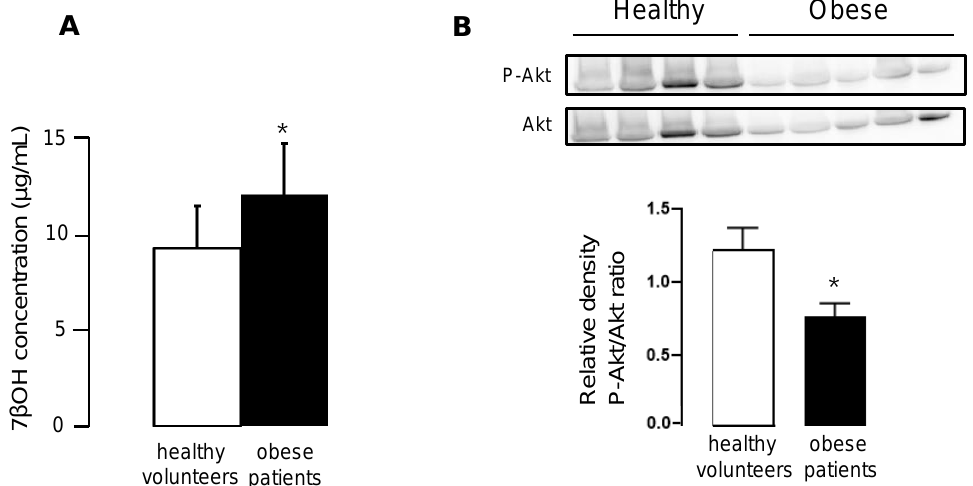
Figure 6. Panel ( A ) Oxysterol concentrations in plasma of sedentary healthy volunteers and obese patients. Panel ( B ) Western blot analysis of Akt and its phosphorylated form in PBMC of sedentary healthy volunteers and obese patients. Values are expressed as mean ± SEM. * p < 0.05 vs. corresponding group.